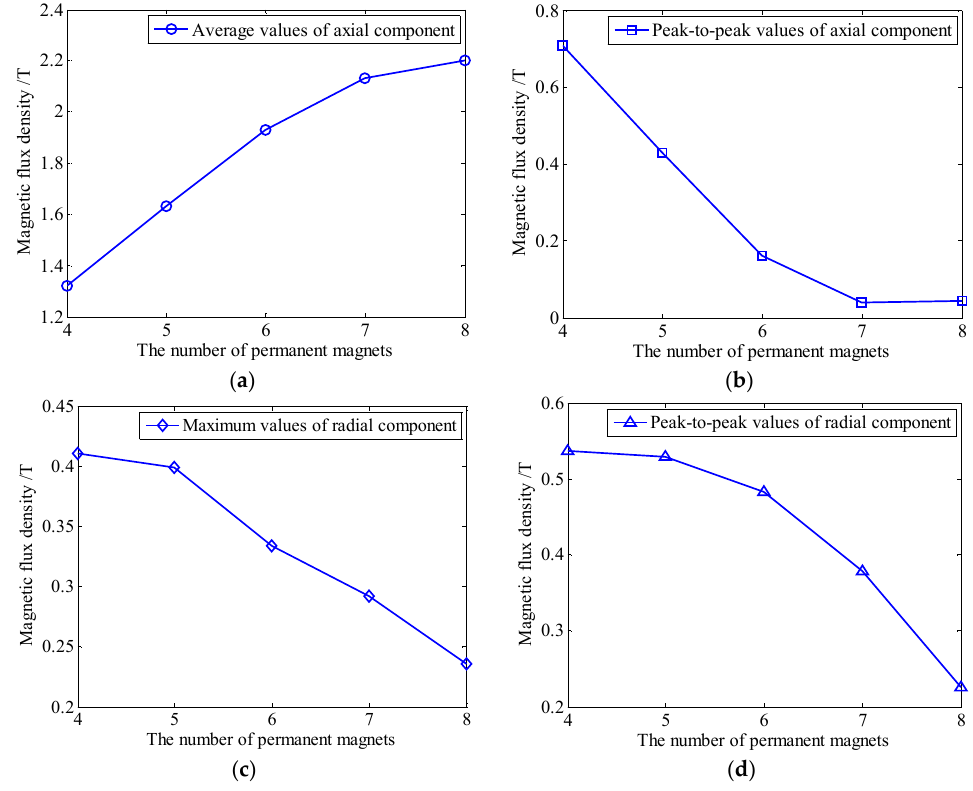
Figure 7. The variation of the static magnetic field with different numbers of permanent magnets along Path 2 ( a ) average values of axial component ( b ) peak-to-peak values of axial component ( c ) maximum values of radial component ( d ) peak-to-peak values of radial component.